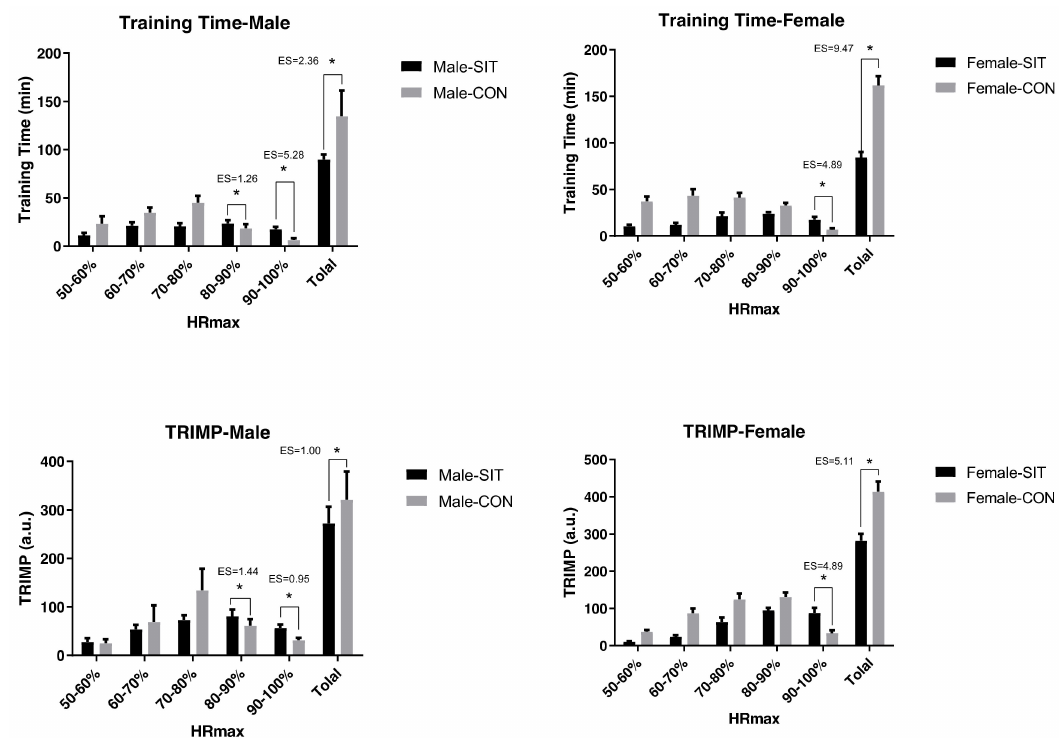
Figure 1. Comparisons of weekly effective training time and training impulse (TRIMP) between SIT and CON groups. Note: * Indicates a significant difference between SIT and CON group, p <